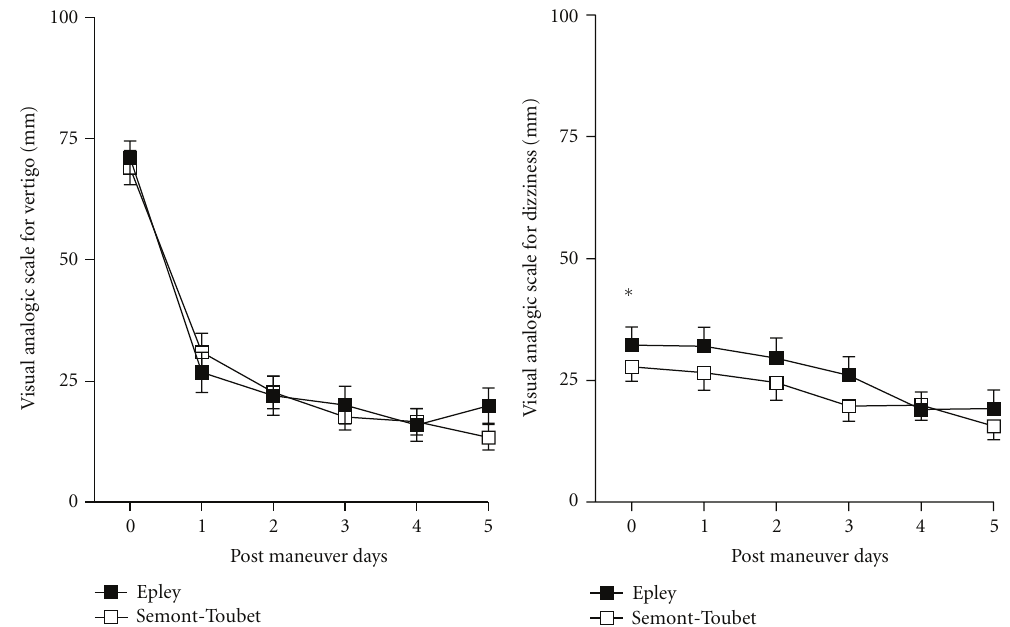
Figure 3: Time course of visual analog scale for vertigo and dizziness following one or two Epley or Semont-Toupet maneuvers: patients had one or two maneuvers of the same type followed by a liberatory nystagmus or vertigo (Epley, n = 58 or ST, n = 79). Patients with a third alternate maneuver were not included in this comparison. Patients with Epley maneuvers had a higher score for dizziness during the first 3 days of observation period. ∗ P < 0 . 05, Epley versus ST for dizziness, 2-way ANOVA.